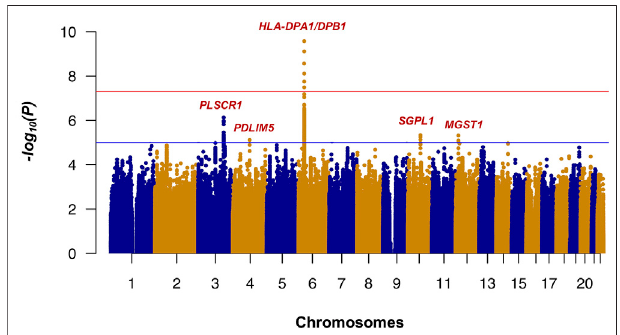
FIGURE1| ResultsoftheGWAS(Manhattanplot)forchronichepatitisB in the Thai population. The HLA-DPA1/DPB1 exhibited the most signi fi cant association with chronic hepatitis B in the Thai population. p -values were calculated using the chi-squared test for 318 patients and 309 controls in the GWAS stage. The horizontal red and blue lines show the genome-wide signi fi cant threshold ( p -value < 5 × 10 − 8 ) and suggestive threshold ( p -value < 1 × 10 − 5 ),